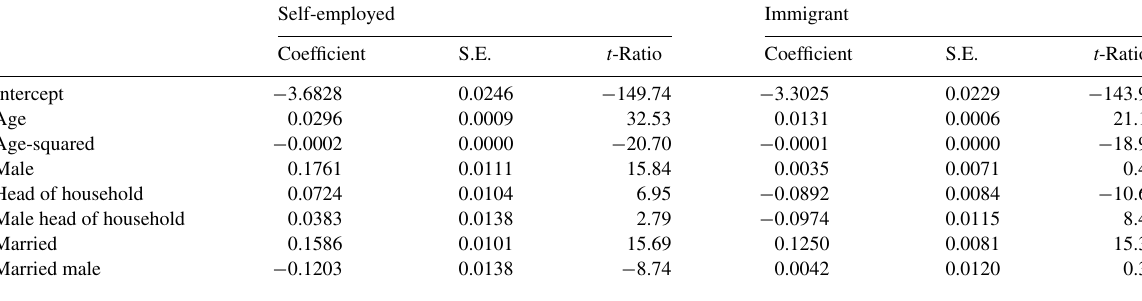
Table 11 Coefficient estimates from the bivariate probit model—African American